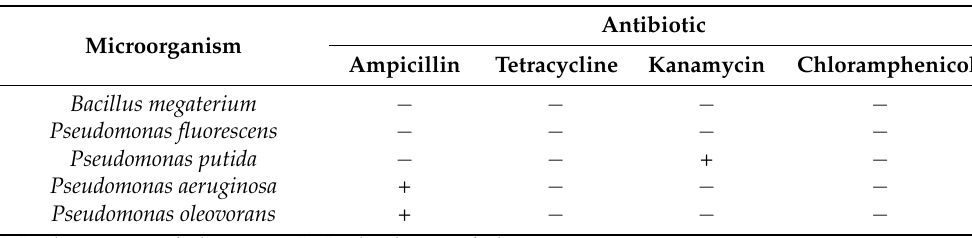
− − − − Pseudomonas fluorescens − − − − Pseudomonas putida − − + − Pseudomonas aeruginosa + − − −